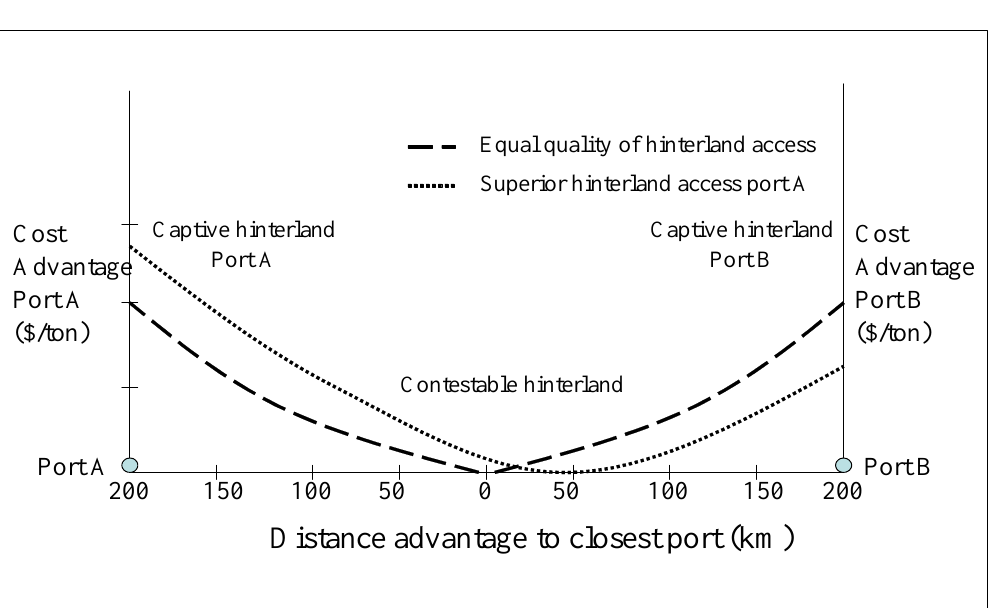
Figure 1. Captive and contestable